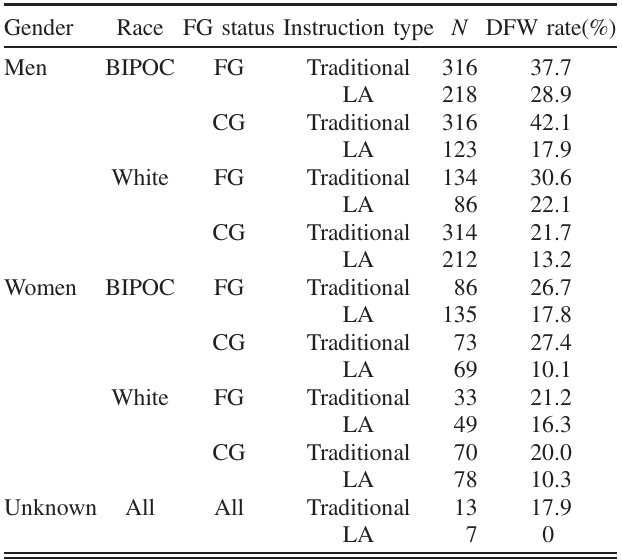
TABLE II. Descriptive statistics disaggregated by demographics and instruction. Gender Race FG status Instruction type N DFW rate(%) Men